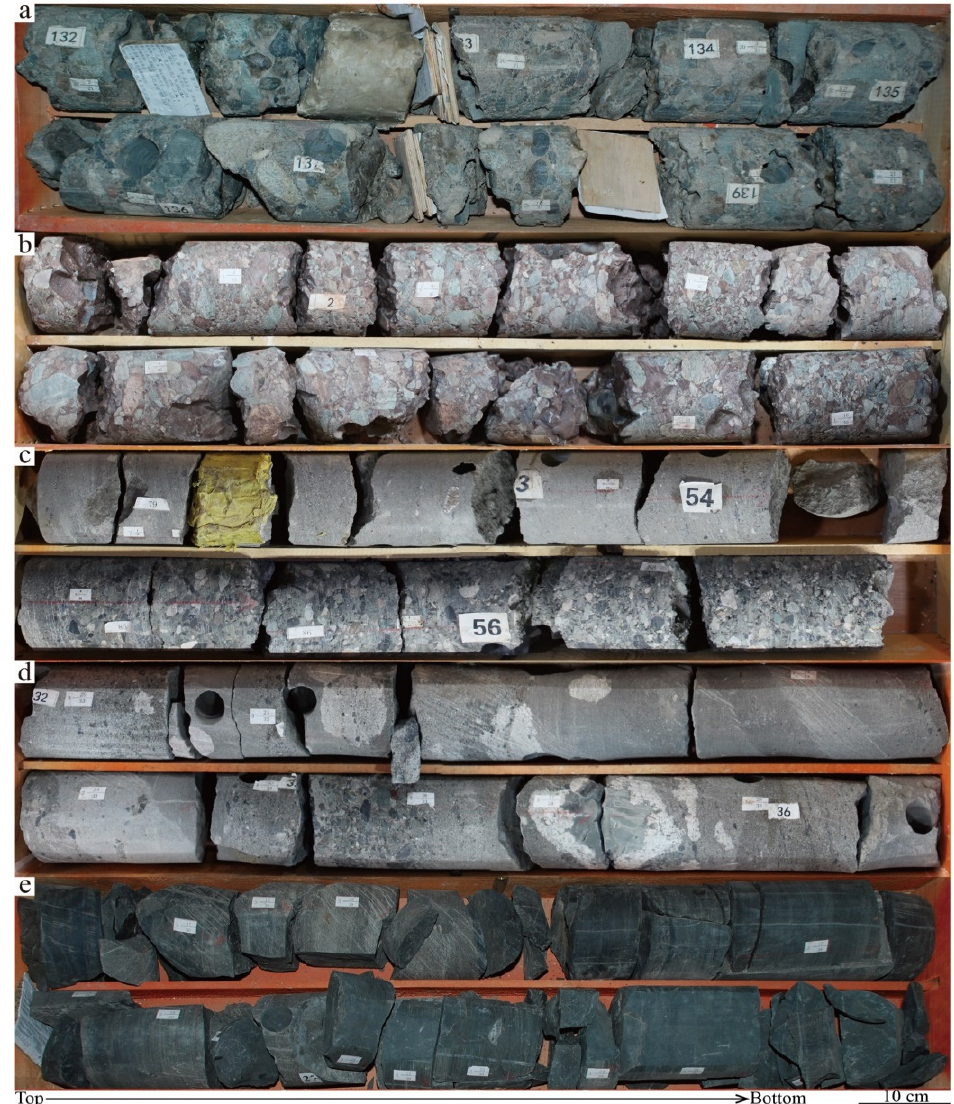
Figure 3. Core characteristics of ( a ) alluvial fan (JL42, 2892.52–2895.34 m), ( b ) fan delta plain (MH25,